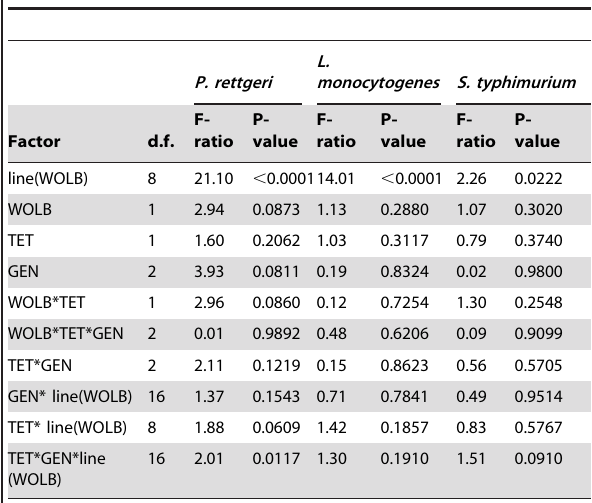
Table 2. Analyses of variance for fixed effects relating genotype, Wolbachia status, tetracycline treatment, and generation to bacterial load.